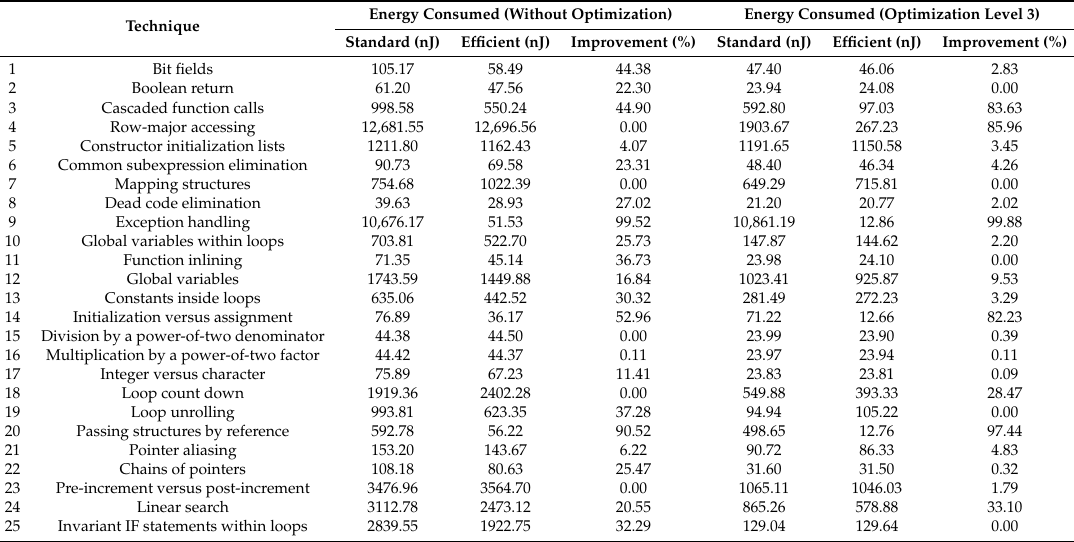
Table 3. Energy results and percentages of improvement in Raspberry Pi